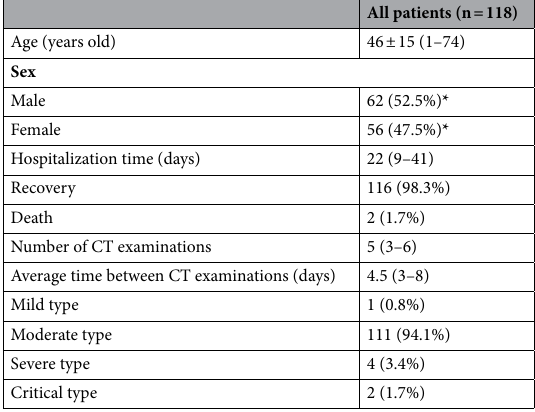
Table 1. Baseline characteristics of the patients with COVID-19. *No significant difference was observed between the sex of two groups, p = 0.435.